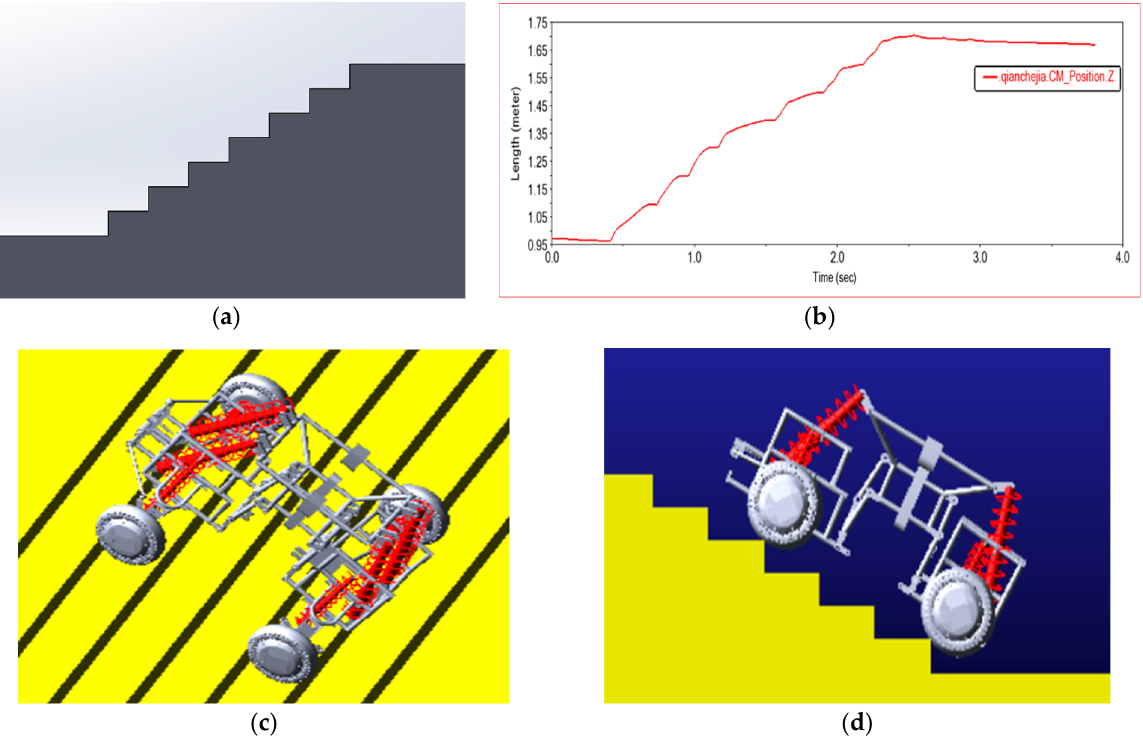
Figure 16. Experimental diagram in Experiment 2. ( a ) Experimental terrain, ( b ) Z-axis displacement of the center of mass of the front frame, ( c , d ) Simulation test process of car climbing stairs.